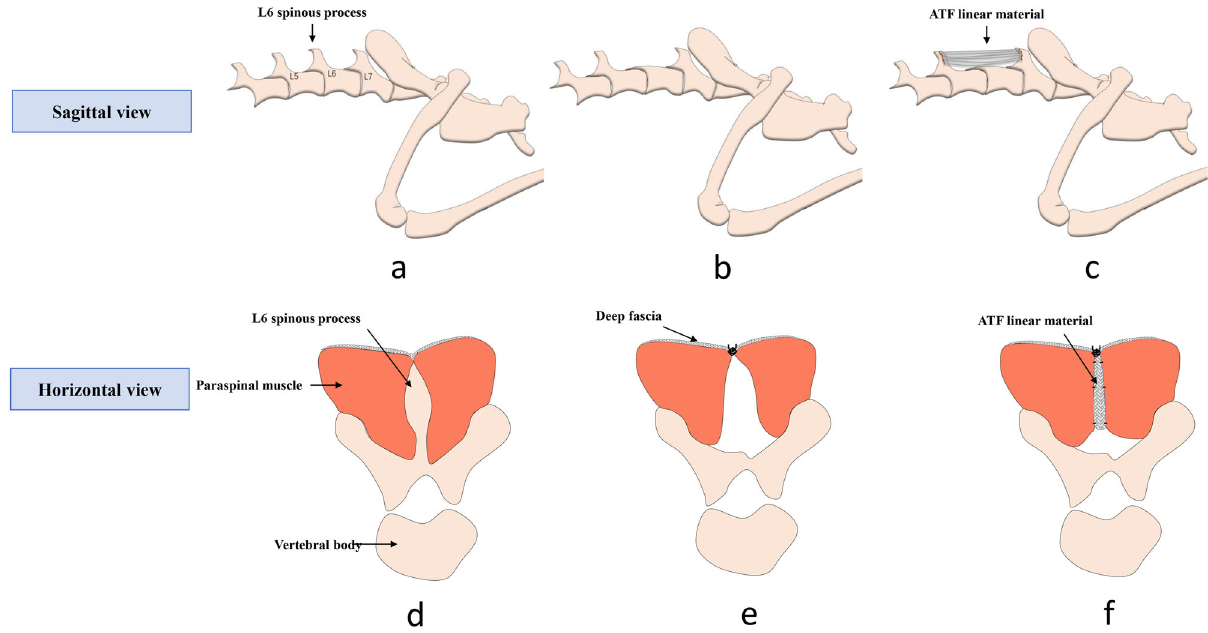
Fig. 1 Rabbit model establishment and material implantation. a Lumbar sacral bone structure; b Resection of L6 spinous process; c Use AFT linear material to fi x between L5 and L7; d cross-section of paraspinal muscle near lumbosacral spinous process; e Direct suture of